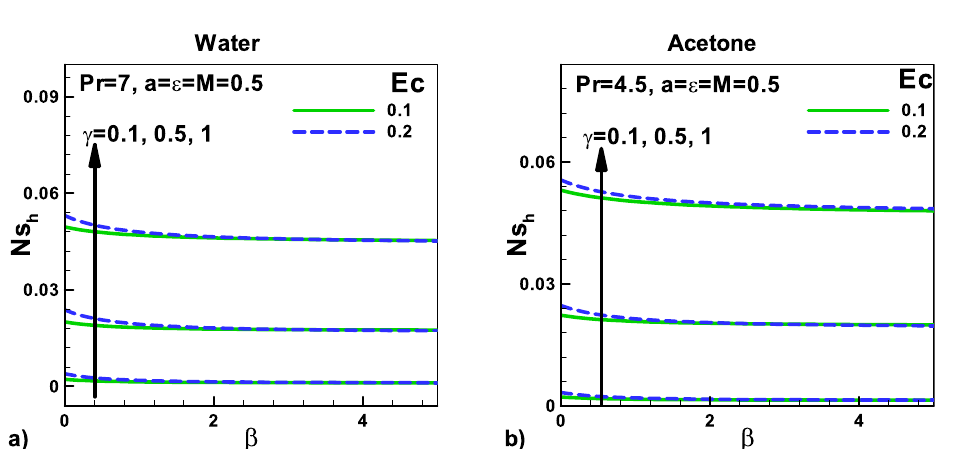
Figure 11. Variation of entropy generation rate due to heat with velocity and thermal slip parameters for ( a ) water ( b ) Acetone.